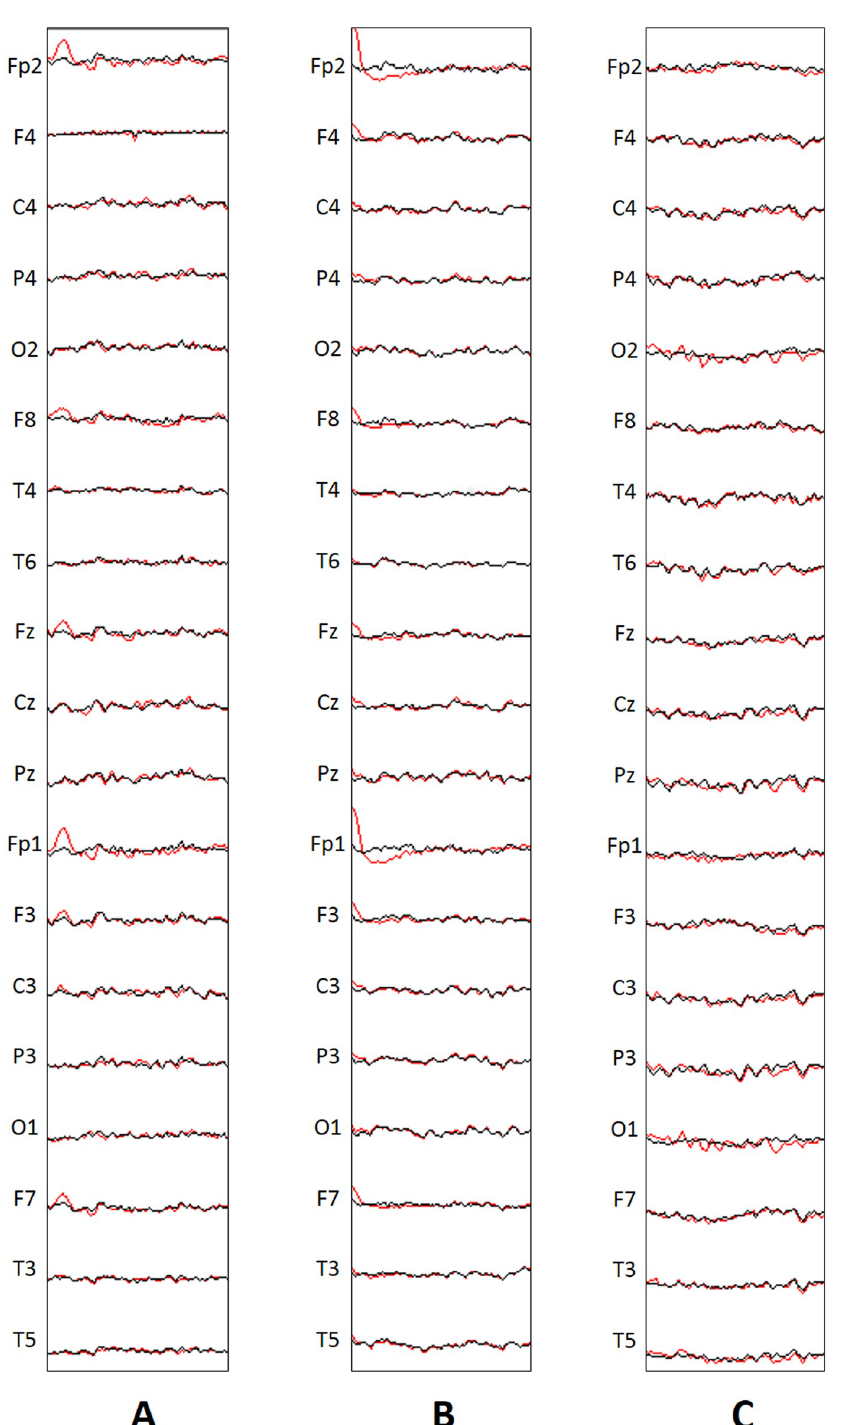
Fig 1. Suppression of muscular and ocular artifacts for selected subjects with HA (A), AA (B) and LA (C). One- second window lengths of raw EEGs with artifacts (red) and corrected EEG (black) are shown.